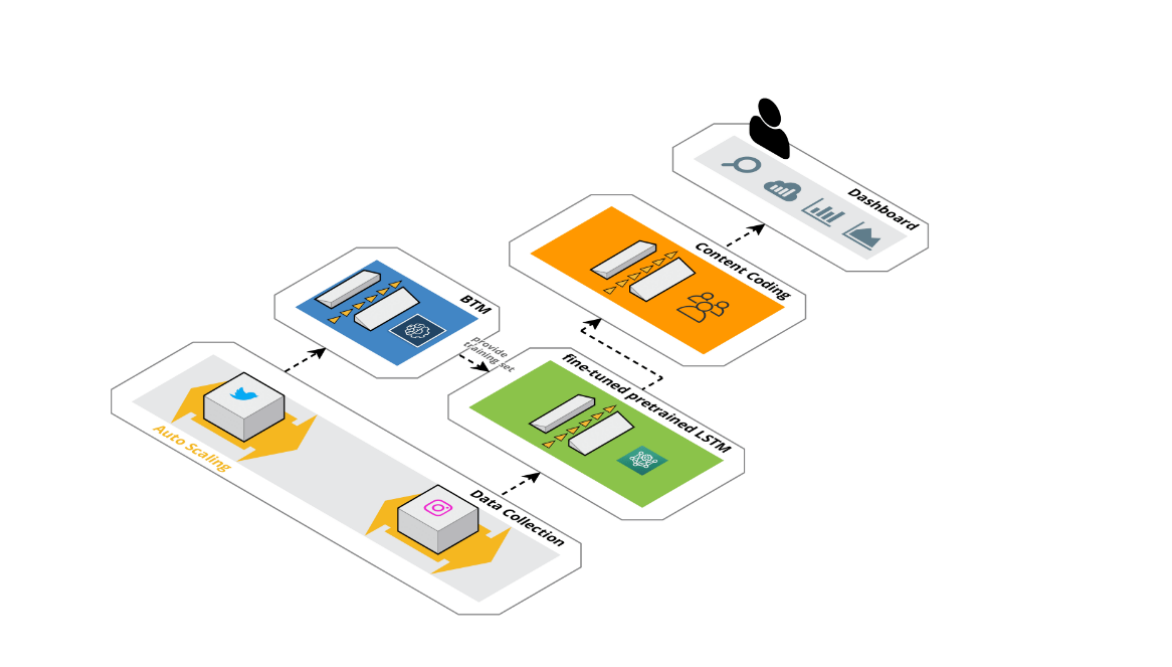
Figure 1. Summary of study methodology. The first phase (yellow) is collection of data from the public streaming Twitter application programming interface and using a web scraper on Instagram to collect social media posts filtered for COVID-19–related keywords; the second phase (blue) used BTM to isolate topic clusters related to COVID-19 product sales to develop an initial training set for classification of posts using a deep learning algorithm (green). Data output by the deep learning classifier was then manually coded for true signals and selling characteristics (orange). Finally, the visualization of labeled data on a customized dashboard to enable public health intelligence and reporting to public health agencies was conducted (grey). BTM: biterm topic model; COVID-19: coronavirus disease; LSTM: long short-term